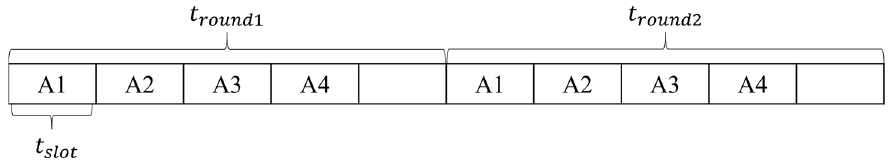
Figure 11. Slots of ranging